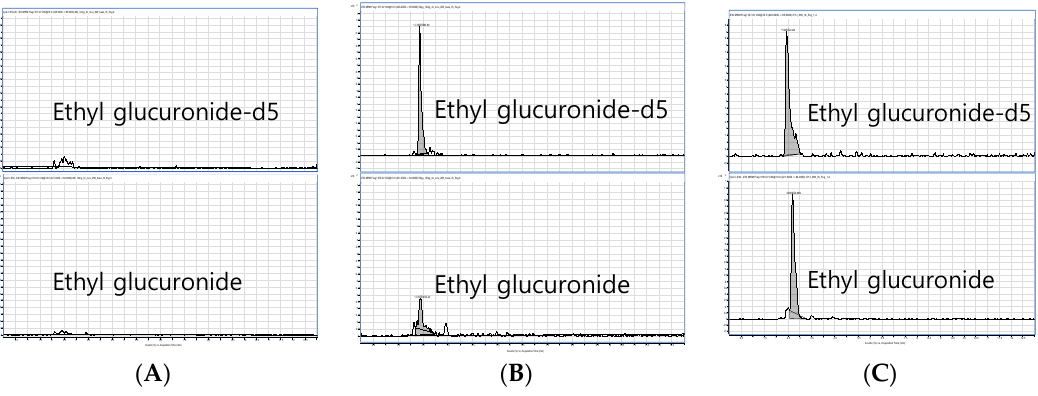
Figure 2. Representative chromatograms of EtG and EtG-d 5 . ( A ) A blank hair sample. ( B ) A fortified hair sample (spiked with the limit of quantification level). ( C ) An EtG-positive sample collected from an alcohol user.